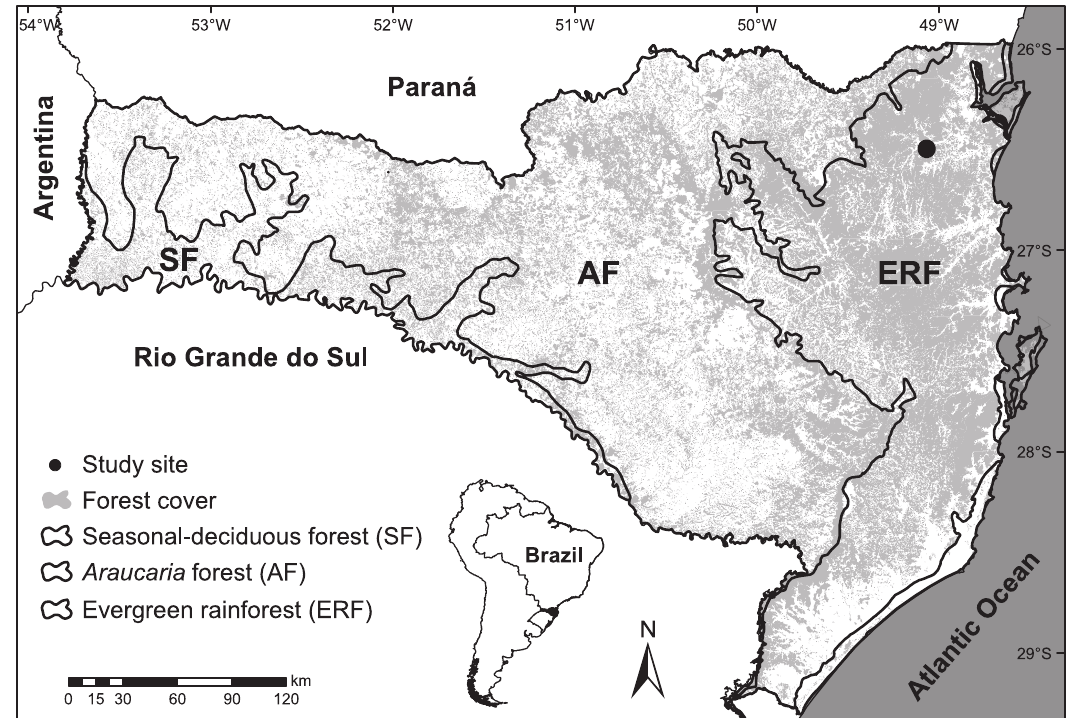
Figure 1 - Santa Catarina state, main forest types (Klein 1978), forest cover (Fundação S.O.S. Mata Atlântica 2009), and location of the study